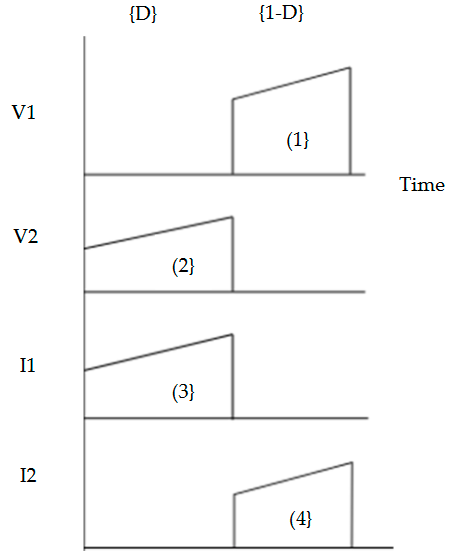
Figure 8. Waveforms during switch ON and OFF conditions.